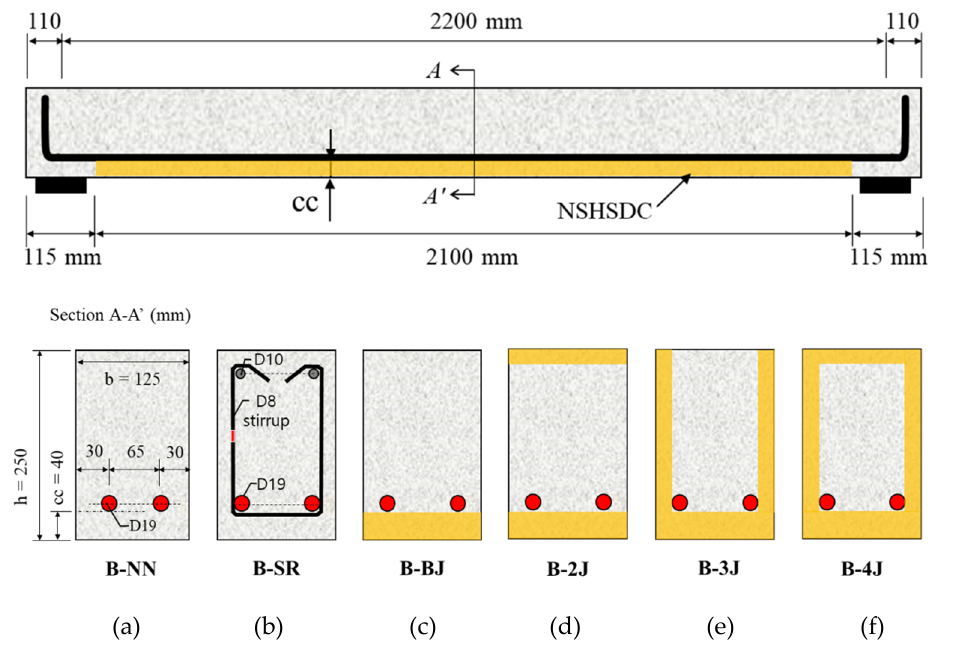
Figure 2. Strengthening schemes of test beams: ( a ) B-NN; ( b ) B-SR; ( c ) B-BJ); ( d ) B-2J; ( e ) B-3J; ( f ): B-4J. Materials 2020 , 13 , x FOR PEER REVIEW